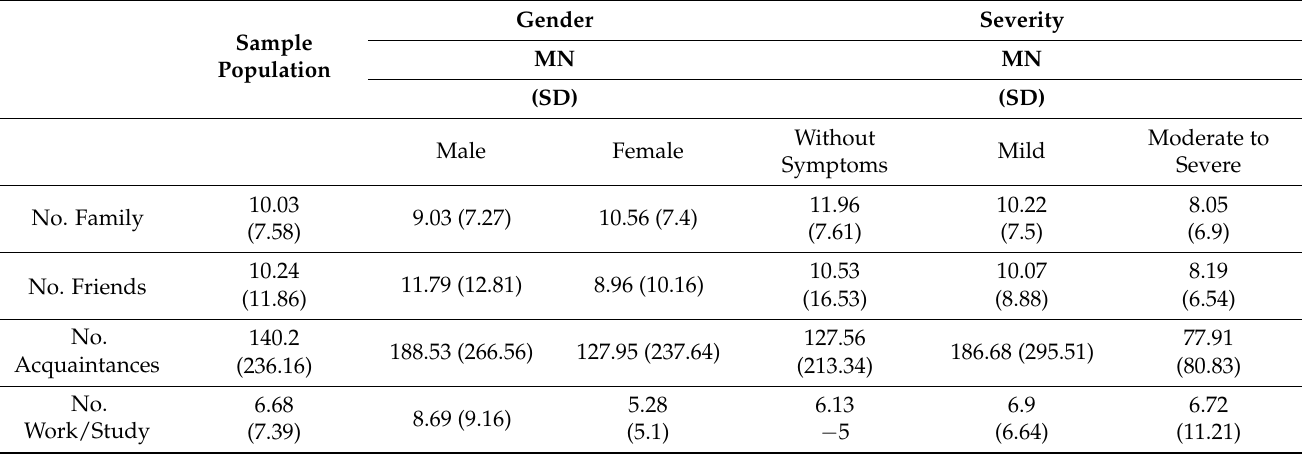
Table 5. Differences in the number of interactions according to gender and severity.